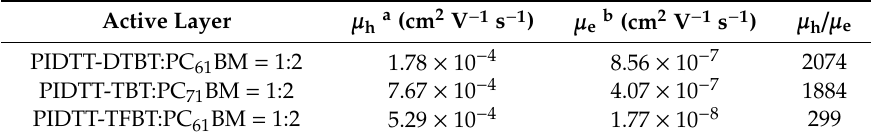
Figure 8. Fitting J 1/2 -V characteristics of hole-only ( a ) and electron-only ( b ) devices based on the studied CPs. Table 4. Mobility of the studied polymers PIDTT-DTBT, PIDTT-TBT, and Table 4. Mobility of the studied polymers PIDTT-DTBT, PIDTT-TBT, and PIDTT-TFBT.